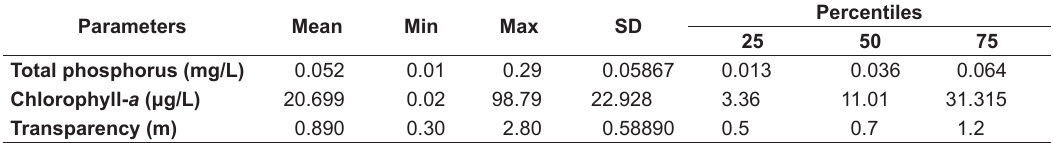
Table 2. Descriptive statistics of correlated parameters.